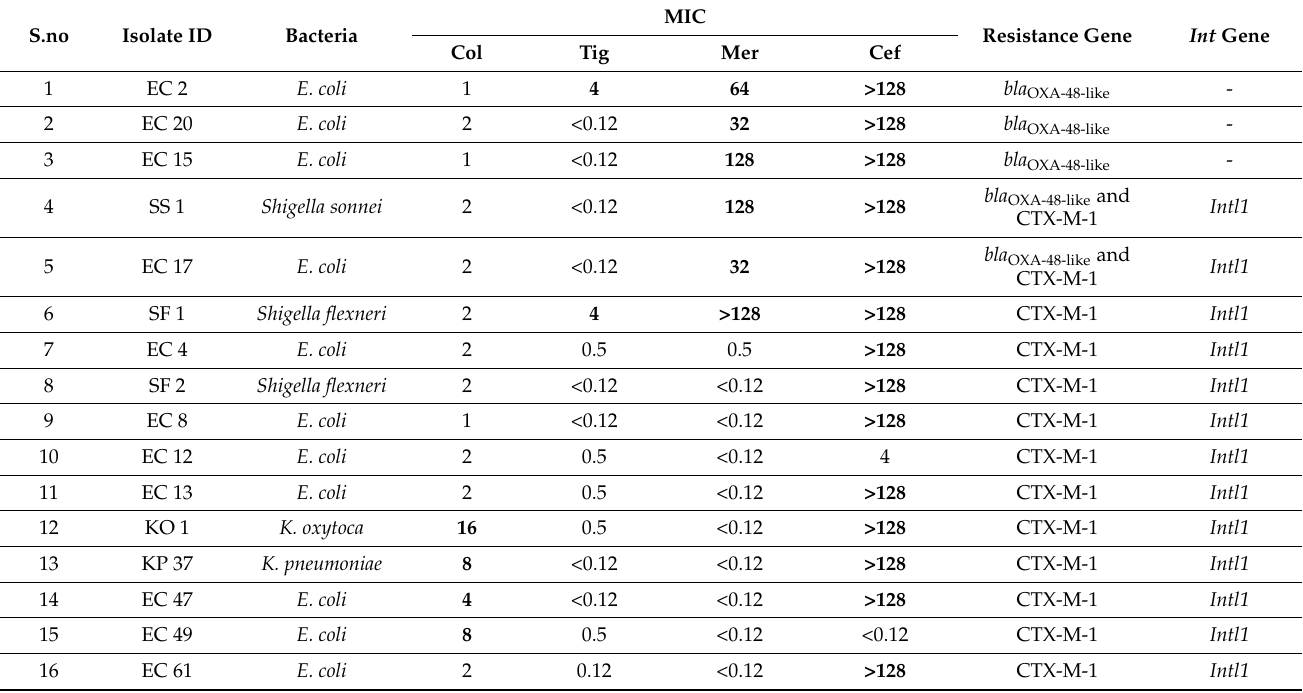
Table 1. The distribution of beta-lactamase genes among clinical Gram-negative bacteria is investi- gated in this